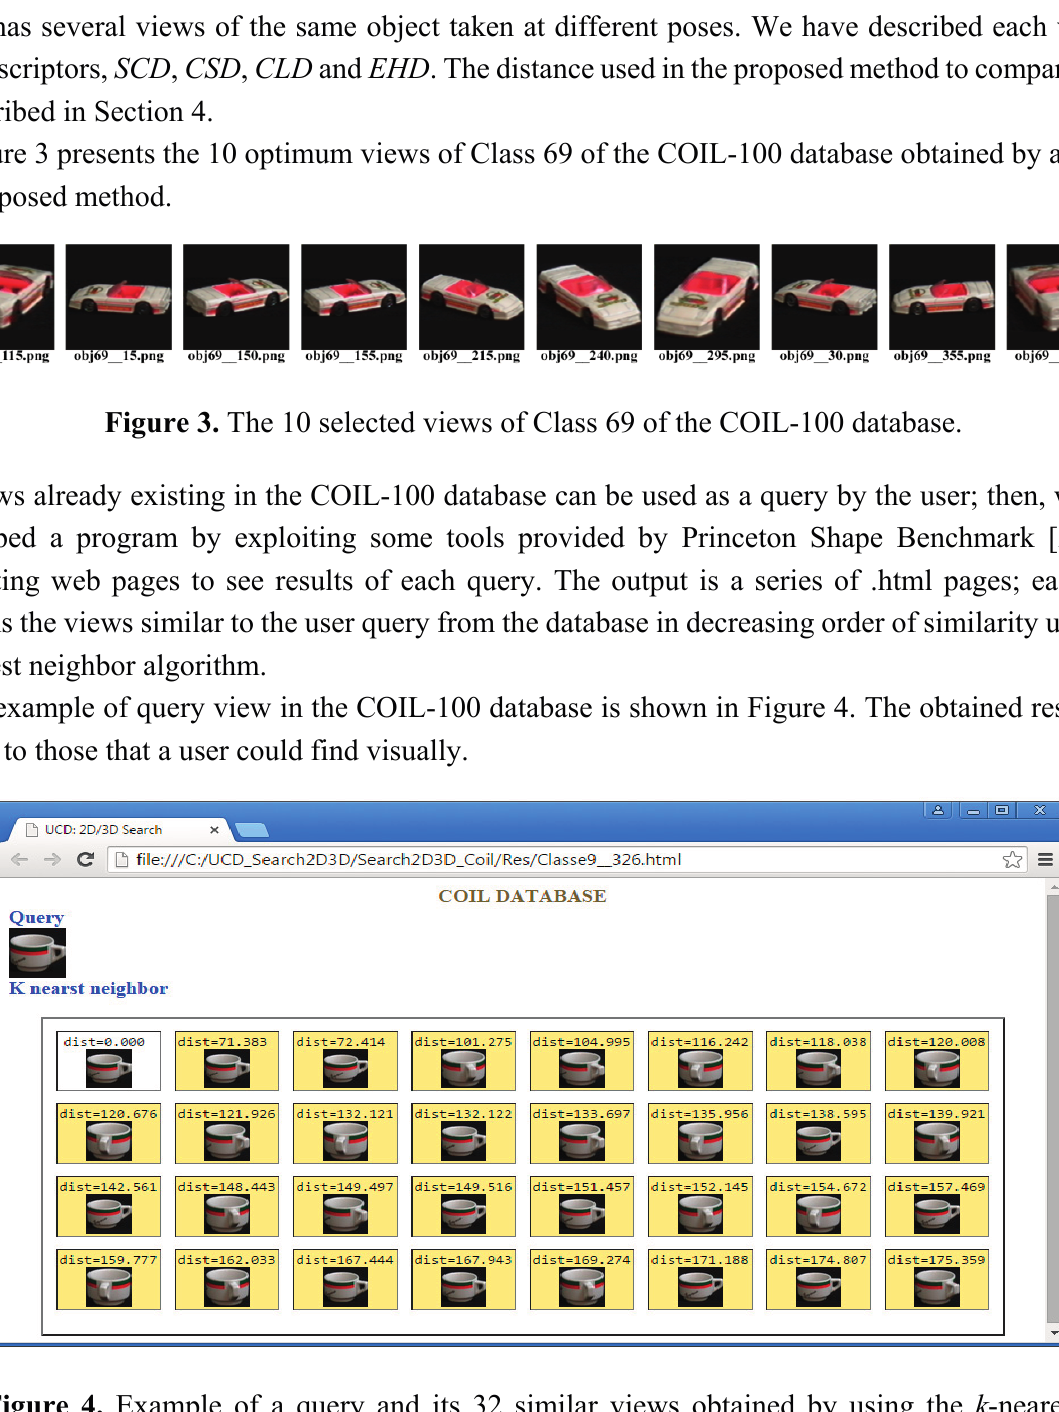
Figure 4. Example of a query and its 32 similar views obtained by using the k -nearest neighbor